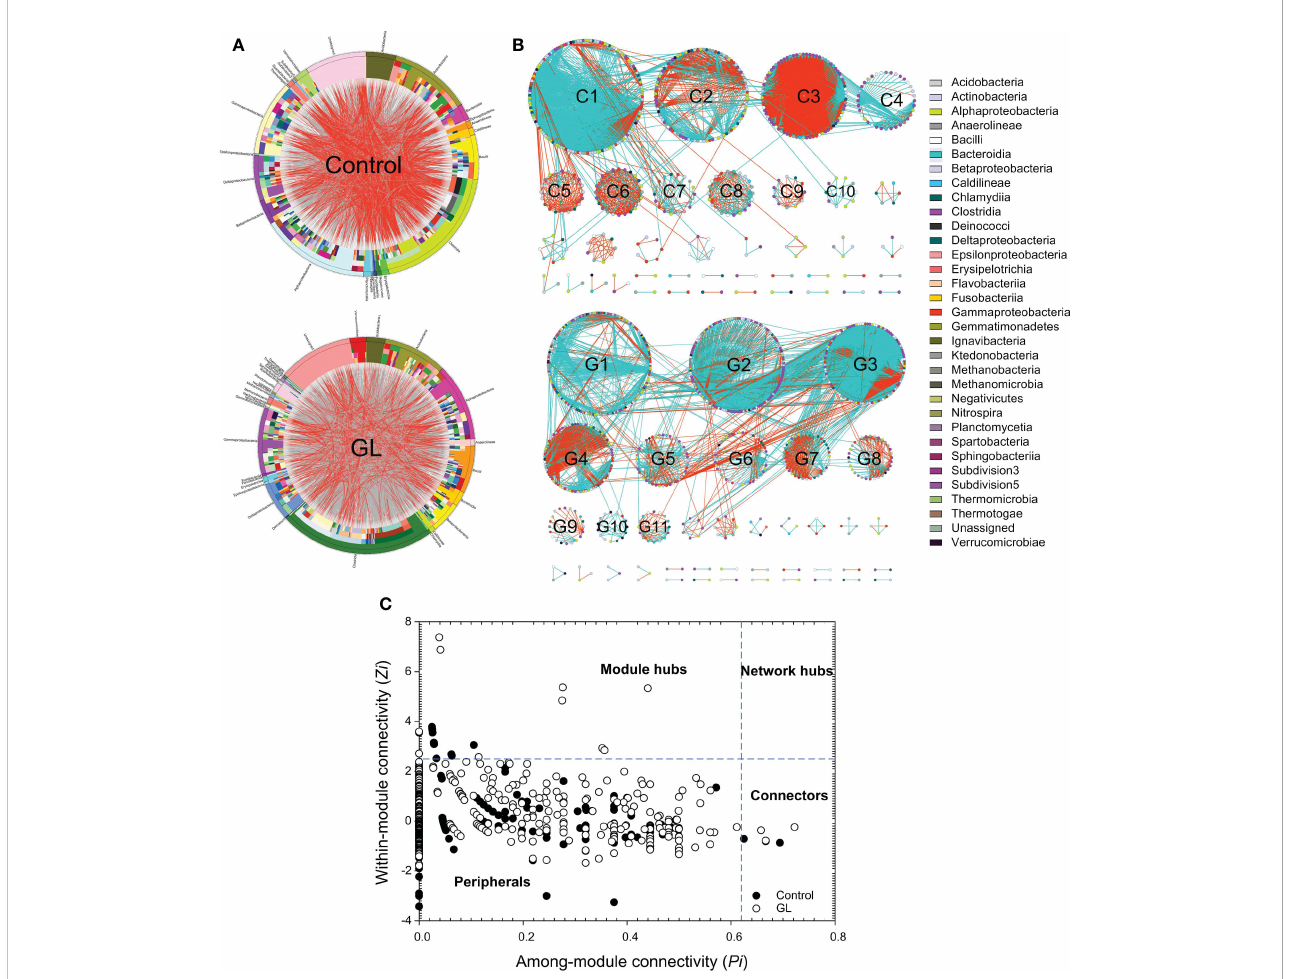
FIGURE 2 The effects of b -1,3-glucan on the interspeci fi c interactions within the intestinal microbial community of Litopenaeus vannamei . (A) Circular plot descriptions of the interaction between different species. The taxonomic levels were class, order, family, genera, and species from the outside to the inside of the circle; (B) Ecological network within the microbial community. The edges (gray edge = positive interaction and red edge = negative interaction) inside the circle and ecological network represent the interactions between species. (C) Z-P plot showing the distribution of OTUs based on their topological